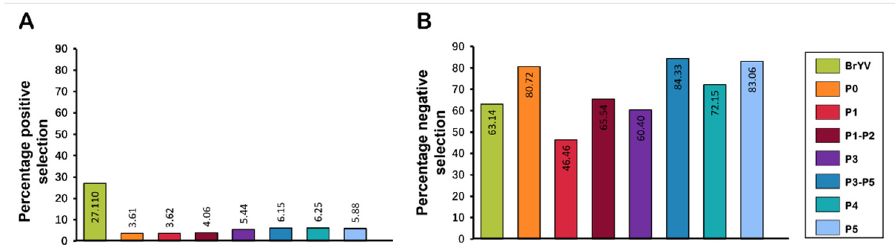
Figure 6. Percentage of sites evolving under negative/positive selection pressure. The datasets include ( A ) percentage of sites evolving under positive selection pressure in BrYV genome and its encoded genes and ( B ) percentage of negatively selected sites in BrYV genome and its encoded genes. Table 4. Estimation of average dN/dS ratios and positive and negative selection for coding se ‐ quences of BrYV.